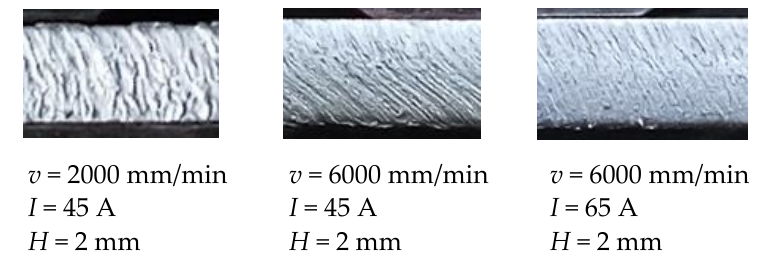
Figure 16. Surface roughness obtained at different process parameters values.